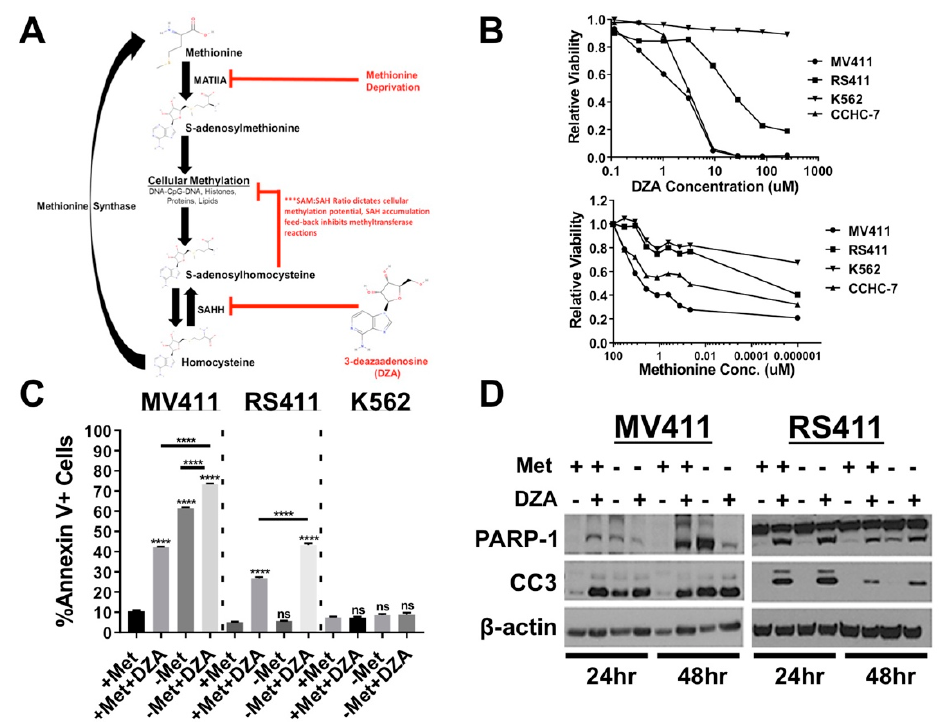
Figure 1. Perturbation of methionine (Met) / S-adenosylmethionine (SAM) metabolism potently induces apoptosis and reduces cell viability in established mixed lineage leukemia rearrangement (MLL-R) leukemia cell lines. ( A ) Simplified schematic of Met / SAM metabolism showing important enzymatic mediators, substrates and products. Deregulation of Met / SAM metabolism and subsequently methylation potential was achieved by targeting two distinct nodes, either by reducing synthesis of the methyl donor moiety SAM by methionine deprivation or pharmacological inhibition of downstream SAH metabolism and methionine recycling. ( B ) Dose and time dependent reduction in relative survival of MLL-AF4 expressing MV411 (AML) and RS411 (ALL) cells treated with increasing concentrations 3-deazaadenosine (DZA) as quantified by Alamar Blue vitality assay 48 h post treatment. K562 cells lacking MLL-fusion expression show no reduction in relative survival upon DZA treatment (left). MLL-R cells also show a greater reduction in cell numbers upon methionine withdrawal as compared to K562 cells (right). ( C ) From left to right; Methionine deprivation or exposure to 15 µ M DZA potently induced apoptosis at 48 h in MV411 cells singly, and the combination showed an additive increase in apoptosis as determined by Annexin V + staining. RS411 cells only undergo apoptosis upon exposure to 15 µ M DZA, and this e ff ect is amplified by methionine deprivation. K562 cells lacking MLL-R show no induction of apoptosis 48 h post DZA exposure or methionine deprivation (Tukey HSD, p < 0.0001). ( D ) Changes in protein expression corresponding with apoptosis induction (PARP-1 and Caspase-3 cleavage) were observed under all experimental conditions in MV411 cells (left), while RS411 cells only undergo apoptosis upon DZA-mediated SAHH inhibition (right).